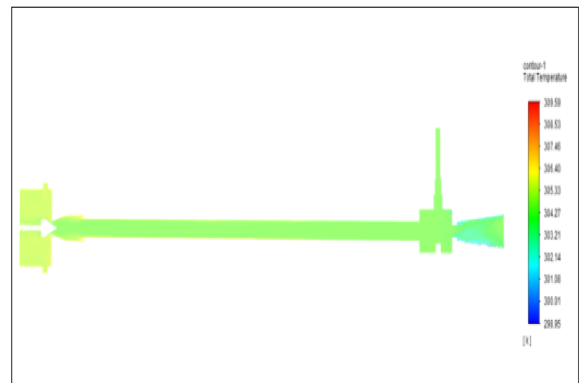
Figure 35. Stainless steel at 10 bar.